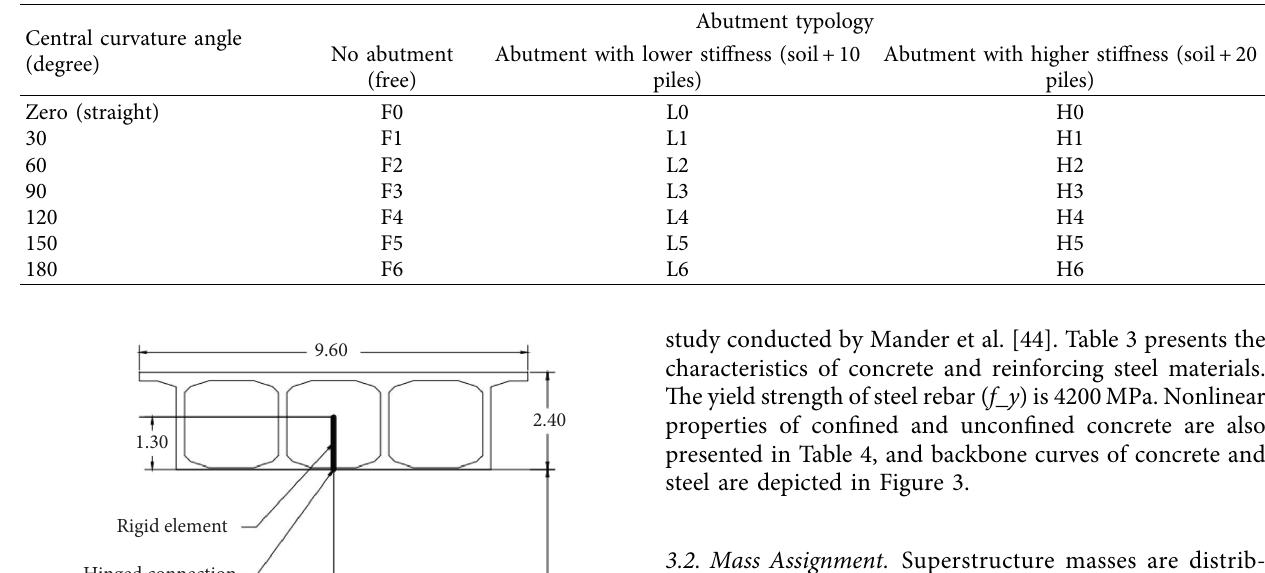
Table 2: Notations used for the defnition of each bridge model.